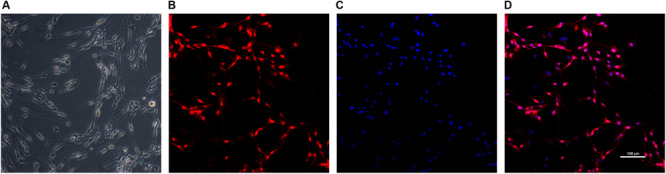
Identification of SCs. The morphology of Schwann cells (A) was observed under light microscope. SCs were immunolabeled for S100β (B) and nucleic acid was signed with DAPI (C). Image (D) was merged from (B,C). Scale bar: 100 μm.